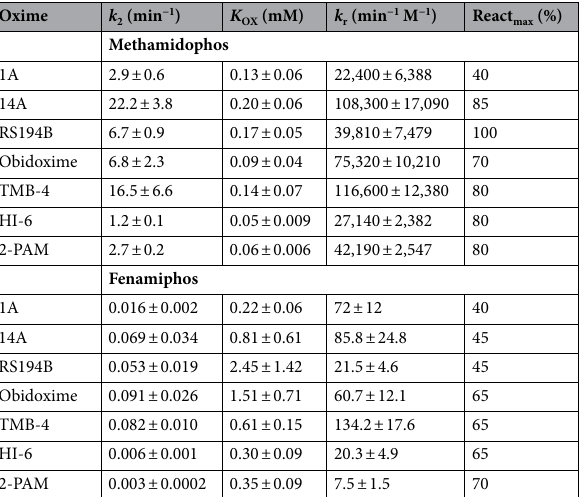
Table 2. Reactivation of methamidophos- and fenamiphos-inhibited hAChE by selected oximes. Kinetic parameters (± SEM): the maximal first-order reactivation rate constant ( k 2 ), the dissociation constant of the phosphylated enzyme-oxime reversible complex ( K OX ), overall second-order reactivation rate constant ( k r ) and maximal percentage of reactivation (React max ) were determined from at least three experiments at 25